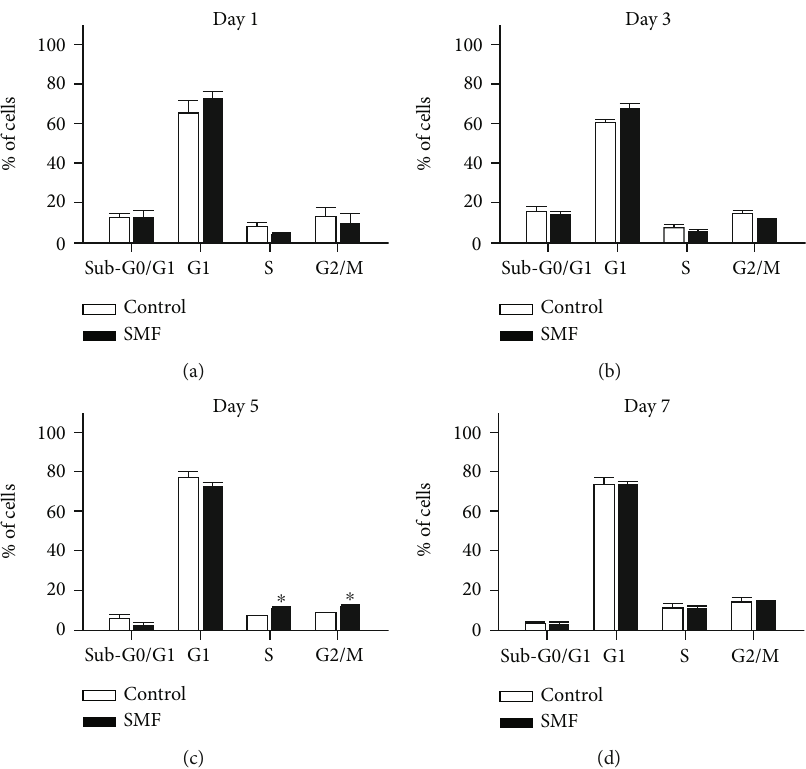
Figure 2: SMF increases self-renewal of mNPCs. Quanti fi cation of cell cycle pro fi les by FACS analysis in mNPC populations under SMF. SMF increased the percentage of cells in S and G2/M phase on day 5 in vitro . Data represent the mean ± S : E : M : ; n = 2 ‐ 4 in each group; ∗ p < 0 : 05 ; Student ’ s t